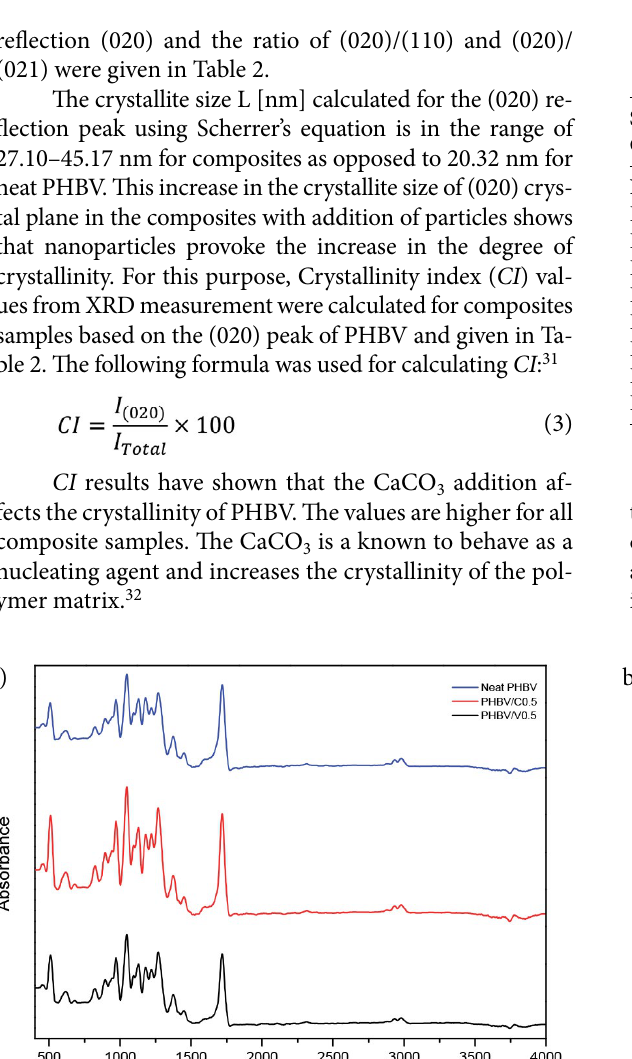
Figure 6. The X-ray diffraction pattern of (a) PHBV/C composites and (b) PHBV/V composites at 2 θ of at 55 ° .